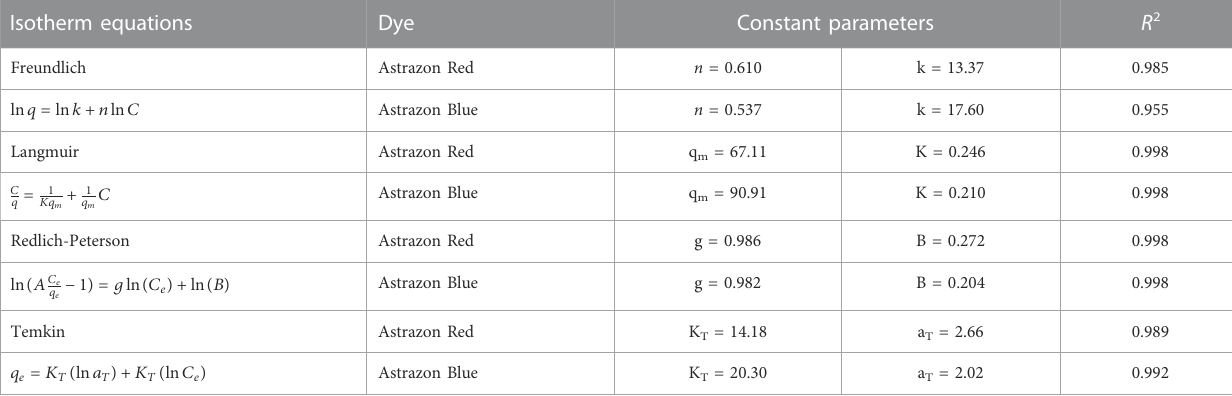
TABLE 4 Constant parameters and correlation coef fi cients calculated for various adsorption models. Isotherm equations